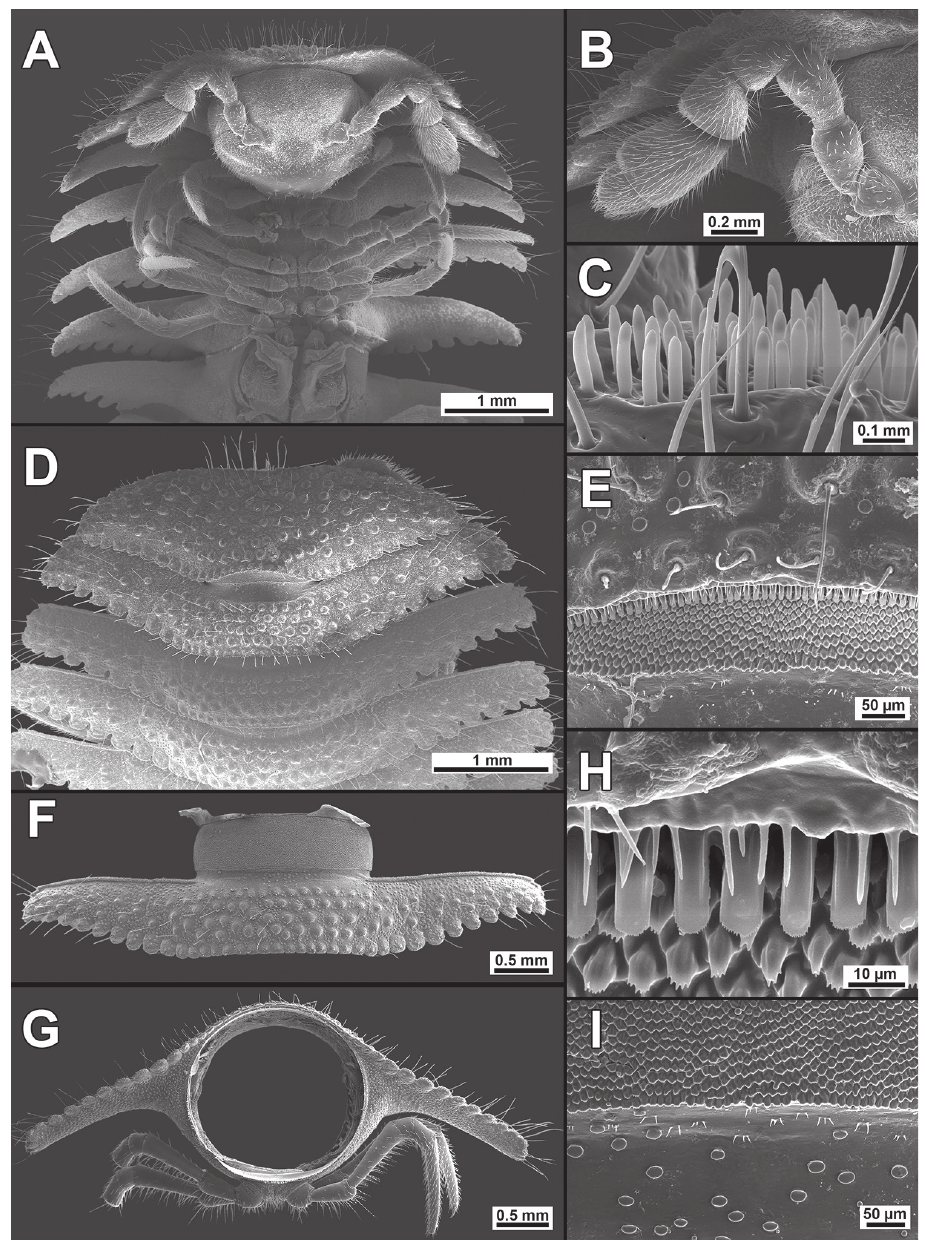
Figure 2. Trichopeltis sutchariti sp. n., ♂ paratype. A, D anterior part of body, ventral and dorsal views, respectively B antenna, ventral view C bacilliform sensilla on antennomere 5, lateral view E prozona of segment 2, dorsal view H limbus of collum, dorsal view F midbody segment, dorsal view G cross-section of a midbody segment, caudal view I enlarged prozona and stricture between pro- and metazona of a midbody segment, dorsal